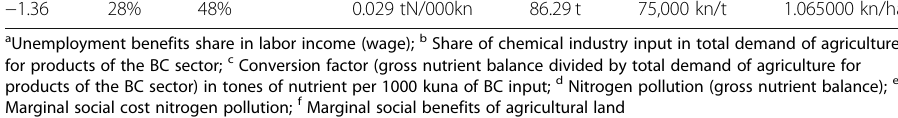
Table 3 Other predetermined parameters